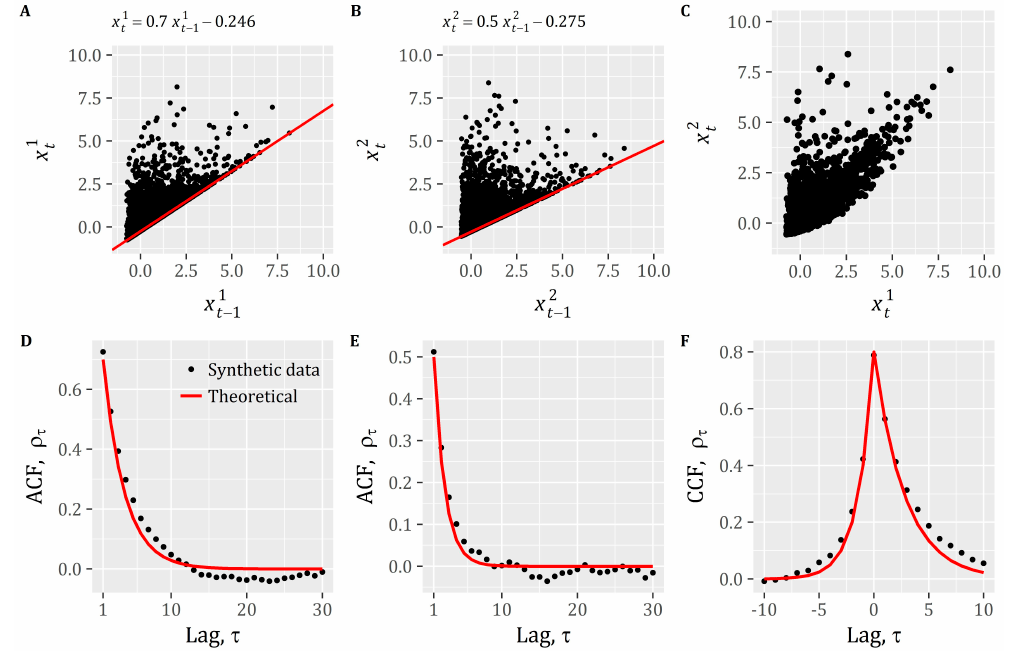
Figure 5. Scatter plots depicting the simulated (using the CMAR(1) model with P III white noise) for ( A ) and ( B ) lag-1 dependence pattern of the autocorrelated processes x 1 and x 2 , respectively, for consecutive time steps (i.e., pair values (•) of the previous and current time steps), while panel ( C ) depicts the contemporaneous dependence (lag-0) of x 1 and x 2 . The red line (—) depicts the envelope equation shown in the title of each plot. Panel ( D ) compares the simulated and theoretical ACF of x 1 while panel ( E ) compares that of x 2 . Lastly, panel ( F ) compares the simulated and theoretical CCF of x 1 and x 2